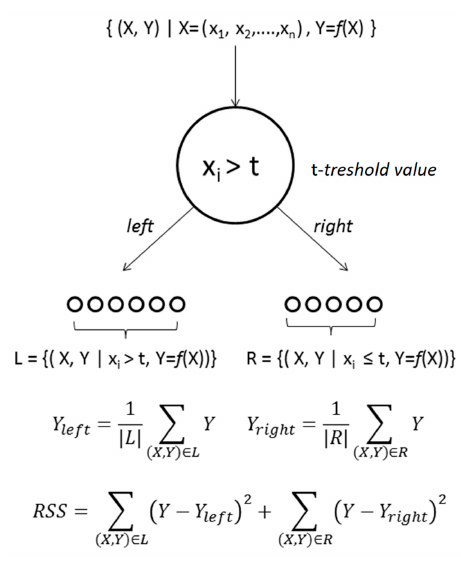
Figure 2. Regression tree node.